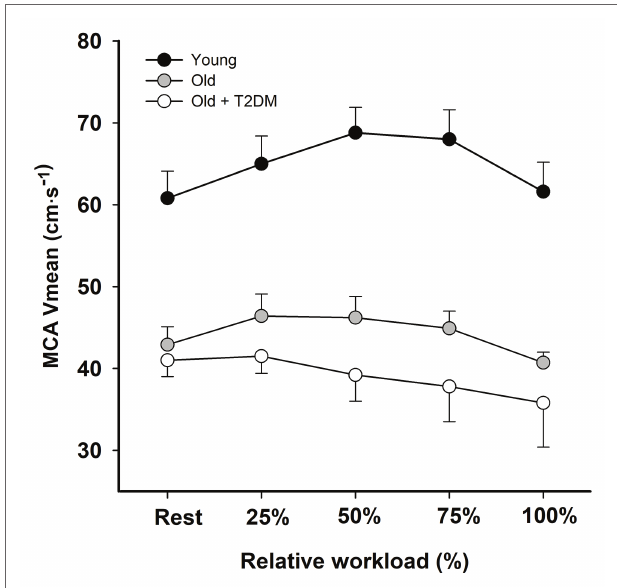
FIGURE 2 | Middle cerebral artery mean blood flow velocity (MCA V mean ) at rest and during exercise at the same relative workload in young individuals (black circles), and in middle-aged subjects without (gray circles), and with type 2 diabetes (T2DM; open circles). During submaximal and during maximal exercise, cerebral perfusion was reduced in older individuals compared with young individuals, and the more so in the older diabetic patients. Values are mean ± SEM (adapted from Fisher et al., 2013; Kim et al.,